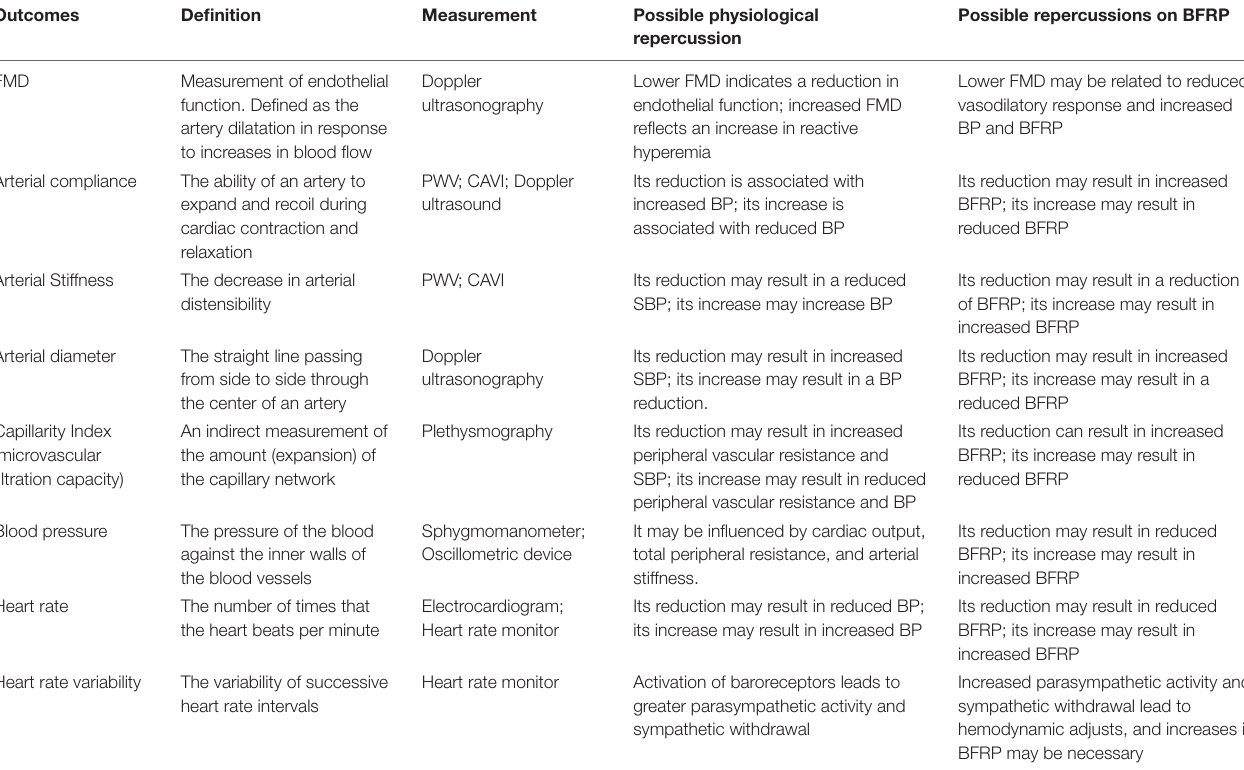
TABLE 1 | Cardiovascular outcomes and their potential impacts on blood flow restriction